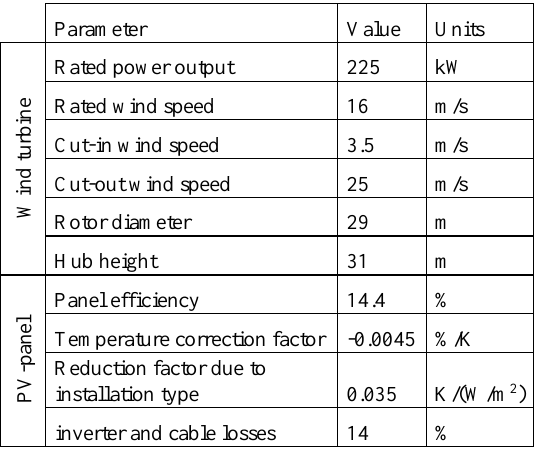
Table 1. Technical parameters of the photovoltaic plants and wind turbines